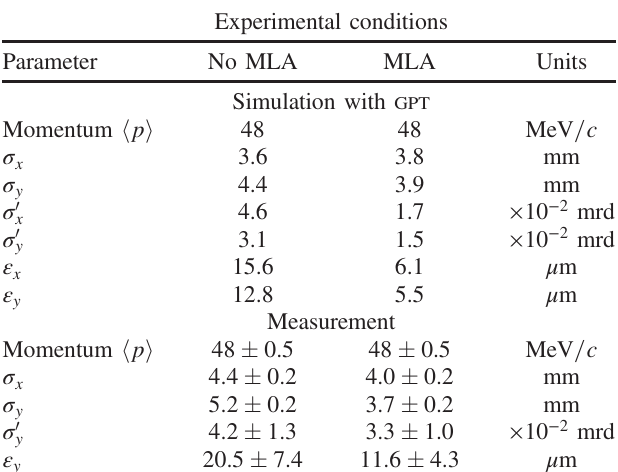
TABLE I. Comparison between measured and simulated beam parameters at YAG5 for Q ¼ 1 (cid:2) 0 . 1 nC. The experimental setup only allowed for the vertical normalized emittance to be mea- sured. The parameters are all given as rms quantities and correspond to the distributions shown in Fig. 6. Experimental conditions Parameter